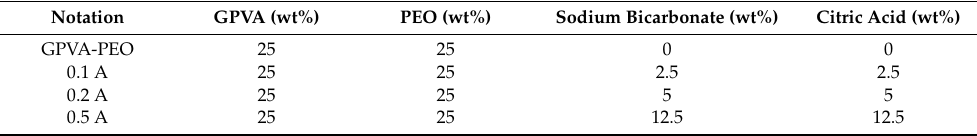
Table 1. Sample notations and chemical compositions of the synthesized